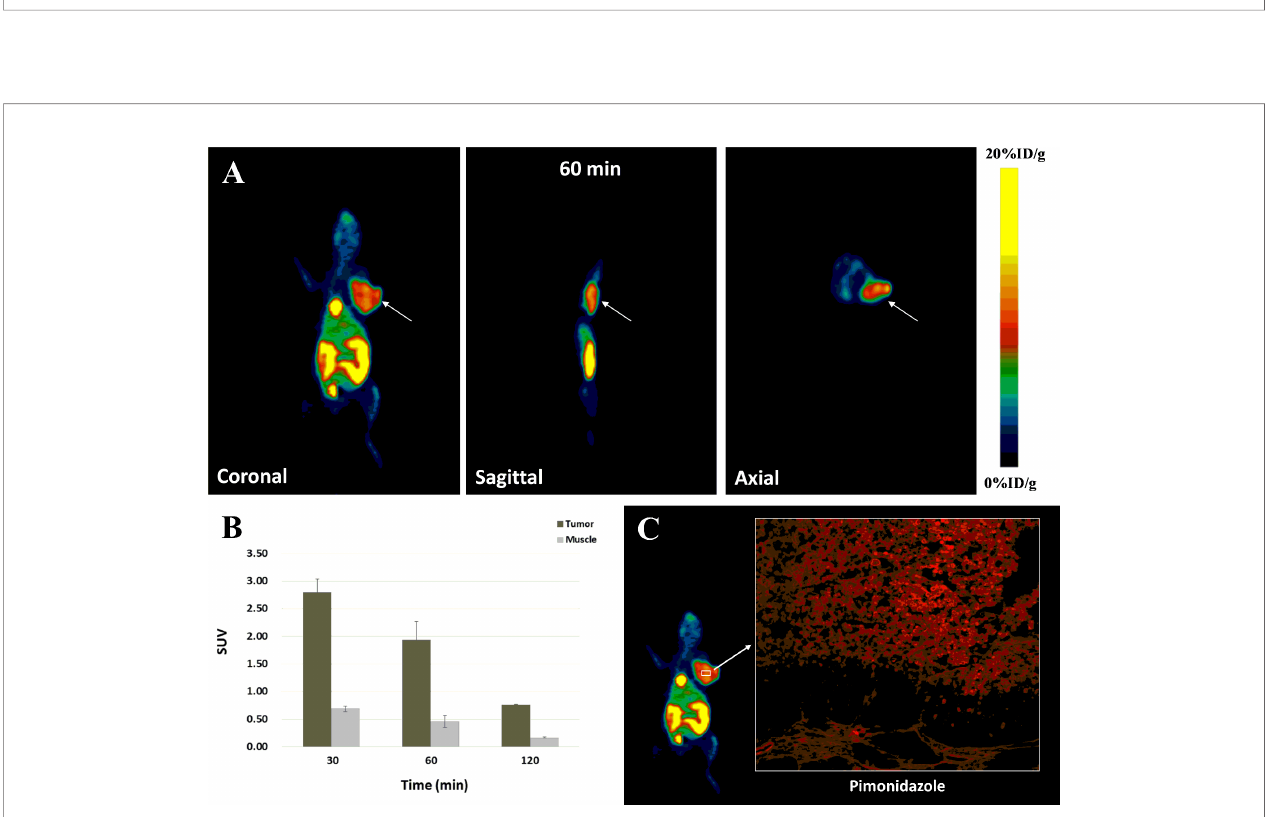
FIGURE 6 | (A) MicroPET images of Al 18 F-NOTA-NI for tumor-bearing mice at 60 min after radiotracer administration (white arrows indicate tumors). (B) ROI-derived %ID/g for tumor and muscle, respectively (n = 4 per time point). (C) Immuno fl uorescence images of Pimonidazole in tissue sections of xenograft tumors (red).